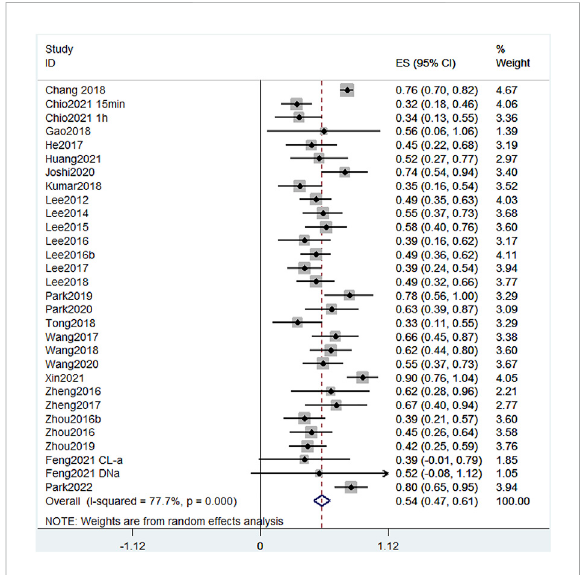
FIGURE 3 Effect size model for EB leakage at 24 h post-treatment. Black dots indicate weighted effect sizes for treatment regimens and error bars indicate 95% con fi dence intervals for each outcome. Heterogeneity of the study is indicated by the I2 statistic. p < 0.001 indicates statistical signi fi cance. At 24 h, studiespresentedaheterogeneityI2scoreof77.7%,alsoindicating a high level of heterogeneity. The effect size of each study except Feng et al. (2021) was also statistically positive, indicating that the treatment signi fi cantly reduced EB leakage in